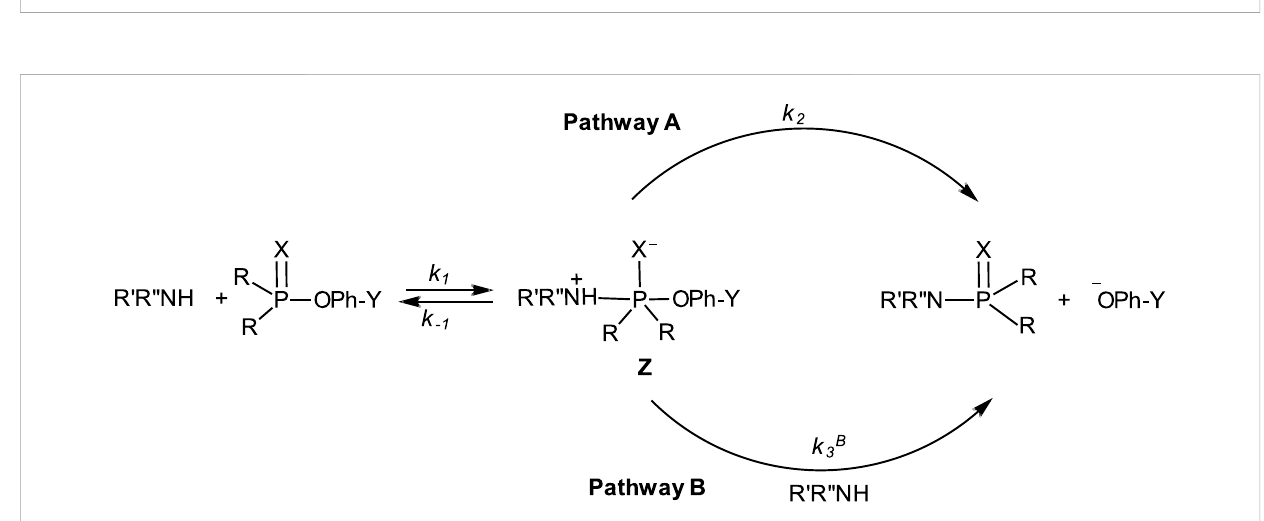
FIGURE 11 The mechanisms for the aminolysis of aryl phosphinates and aryl phosphinothioates by a diversity of amine types – primary, secondary, and di- amines – in acetonitrile. See Cook et al.